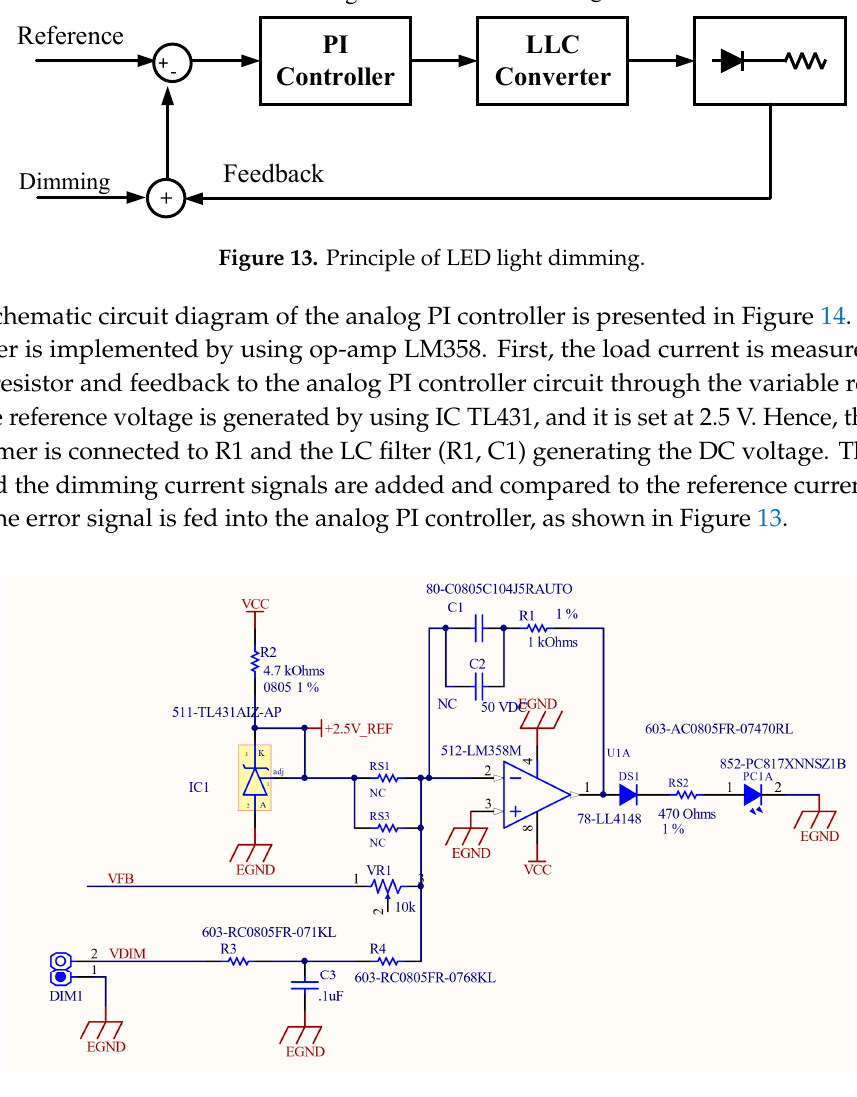
Figure 14. Schematic circuit diagram of the analog proportional–integral (PI) controller.